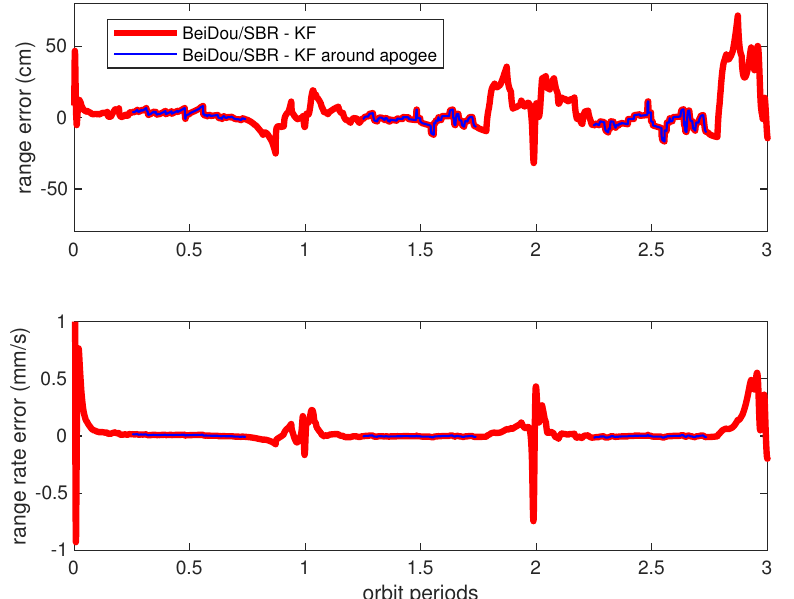
Figure 11. Range and range rate estimation errors from BeiDou/SBR equipment. The red lines denote the estimation errors, and the short blue lines denote the same data during apogee time. KF: traditional Kalman filter.